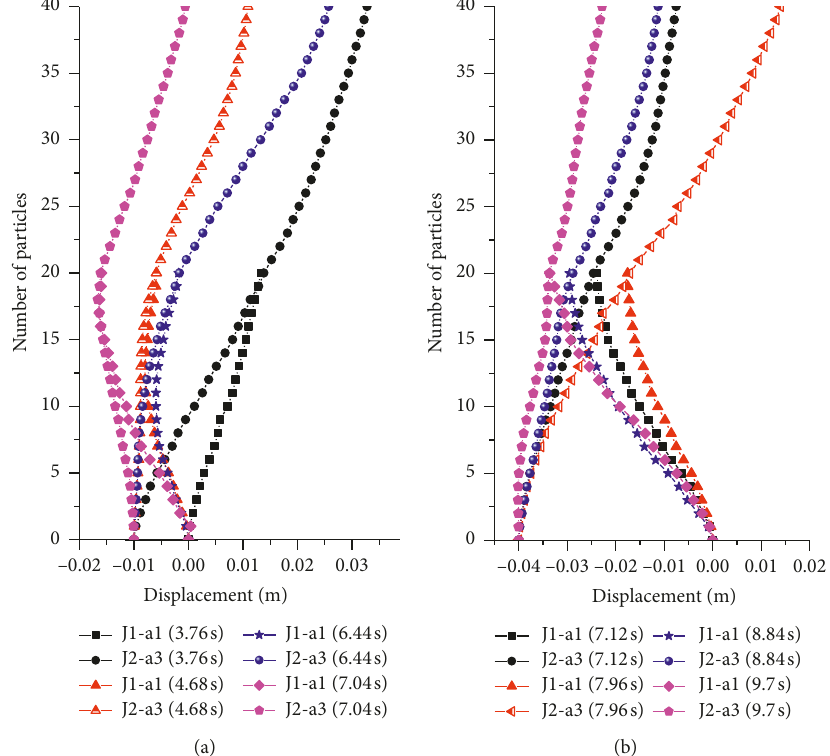
Figure 23: J 1 -a 1 , J 2 -a 3 deformation diagram of the structure pounding moment under the excitation of El Centro wave (35m/s and (b)